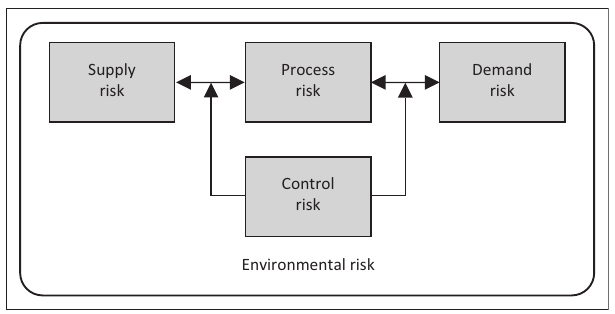
FIGURE 2: Sources of risk in the supply chain.